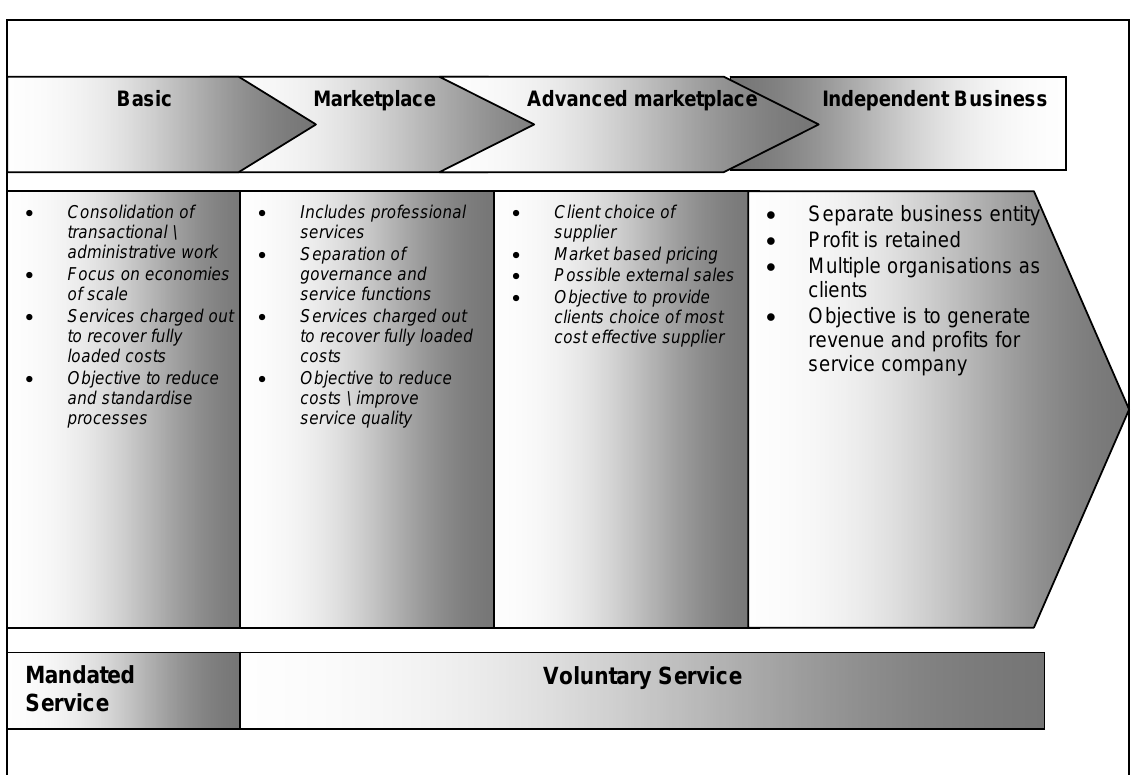
Figure 5: Independent business unit model